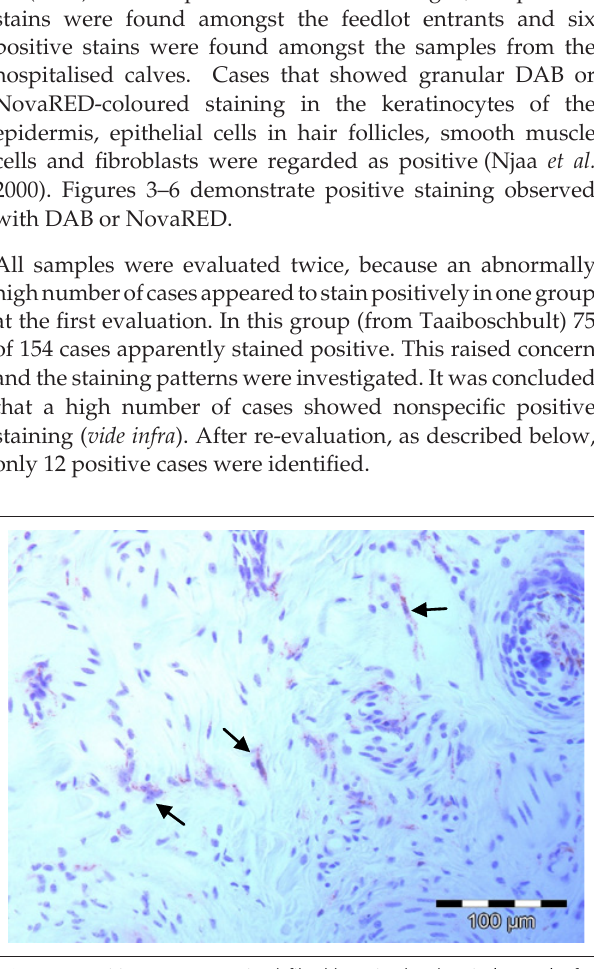
FIGURE 3: Positive diaminobenzidine staining in the keratinocytes of the epidermis (top arrow) and hair follicle epithelium (middle and bottom arrow) of a persistently infected calf (Magnification: 40x).